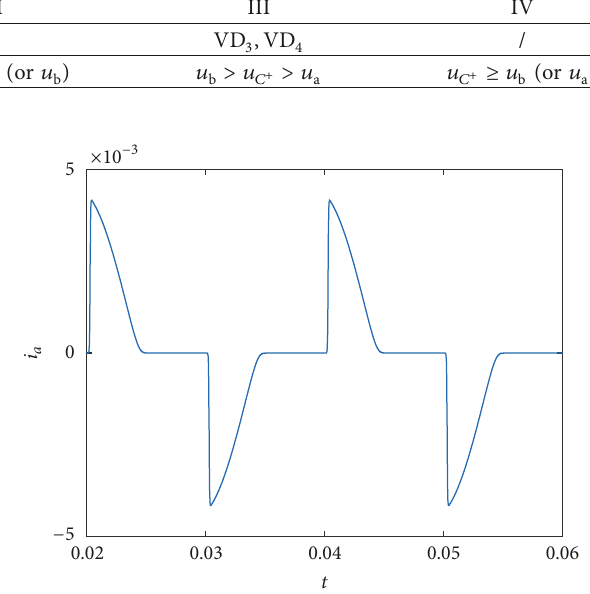
Figure 7: Input current of a phase versus time t .